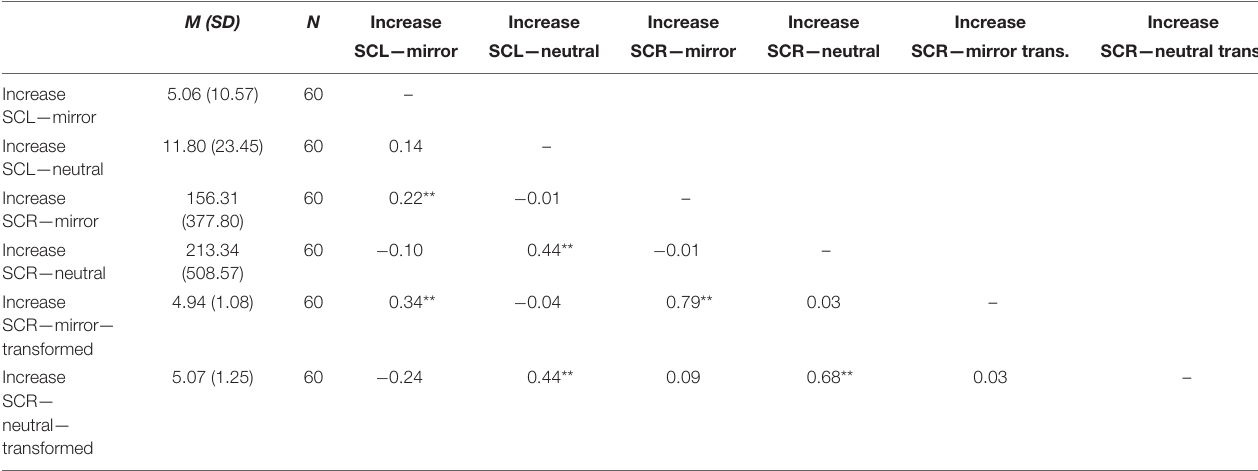
TABLE 3 | Correlation matrix of % increase in skin conductance